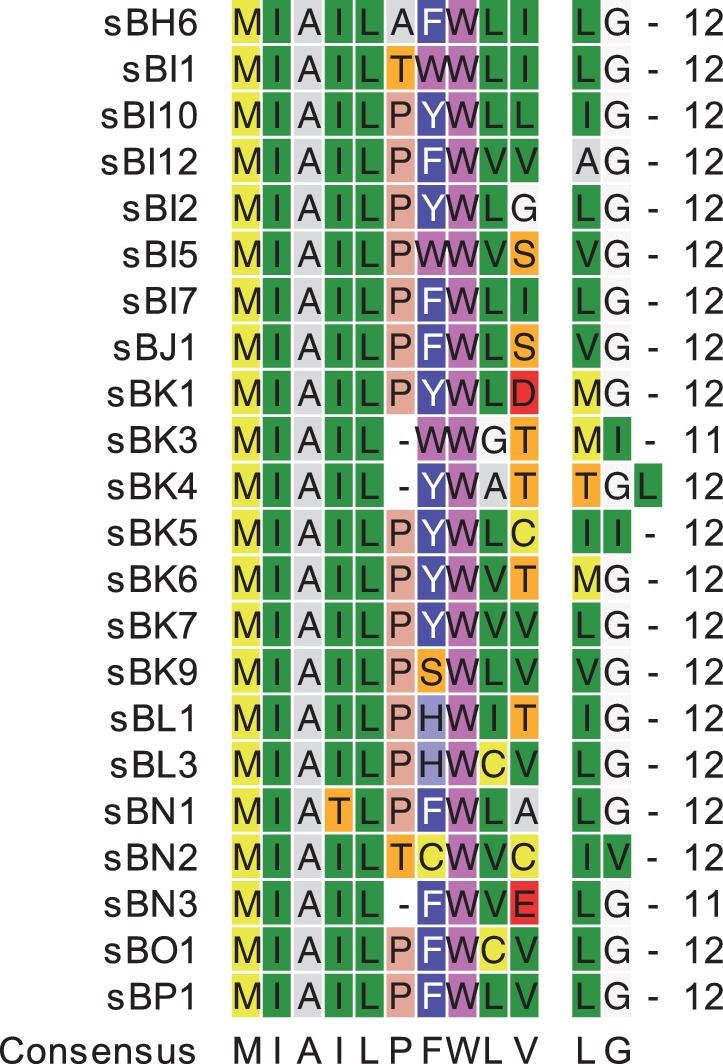
Sequence conservation of ScuR/SarF activating peptides.Sequence alignment of the 22 peptides activating ScuR or SarF. Residues are color-coded according to the Rasmol color scheme. The consensus sequence is shown underneath with the following nomenclature. The formatting of the multiple alignment has been generated using CLC Main Workbench 7 (https://www.qiagenbioinformatics.com/).